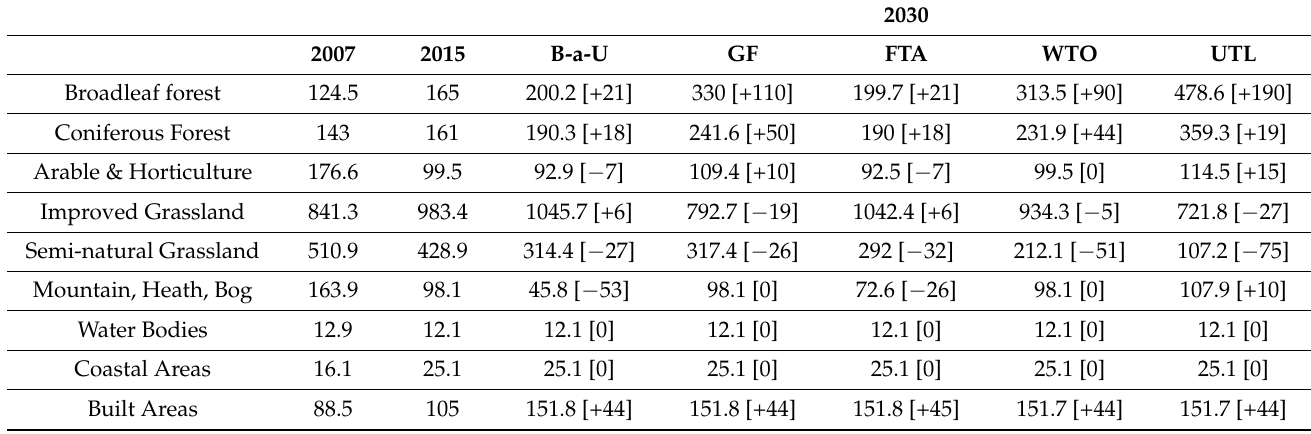
Table 2. Area of each LULC category, historical observations in 2007 and 2015 (in ‘000 hectares). Business-as-usual (B-a-U), Green Future (GF), Free Trade Agreement (FTA), World Trade Organisation (WTO) and Unilateral Trade Liberalisation (UTL) translate effects of hypothesised policy changes to LULC transitions. Numbers show predicted area (in ‘000 hectares), square brackets indicate percentage changes of each LULC between 2015 and 2030. Total area of Wales is 2.078 million ha.